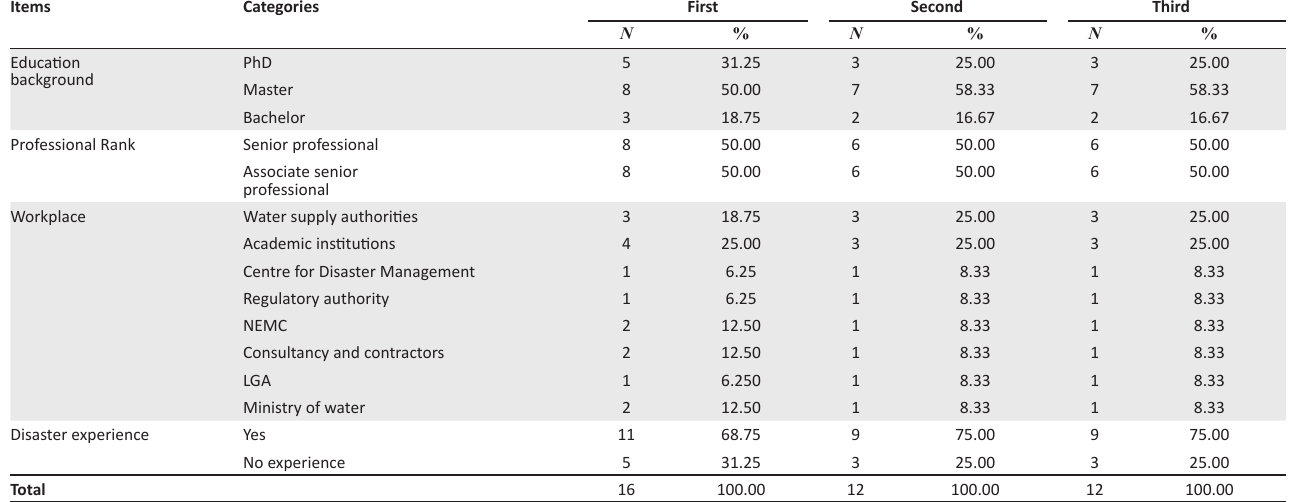
TABLE 6: Qualification of the experts involved in the three-round Delphi study for developing economic resilience tool. Items